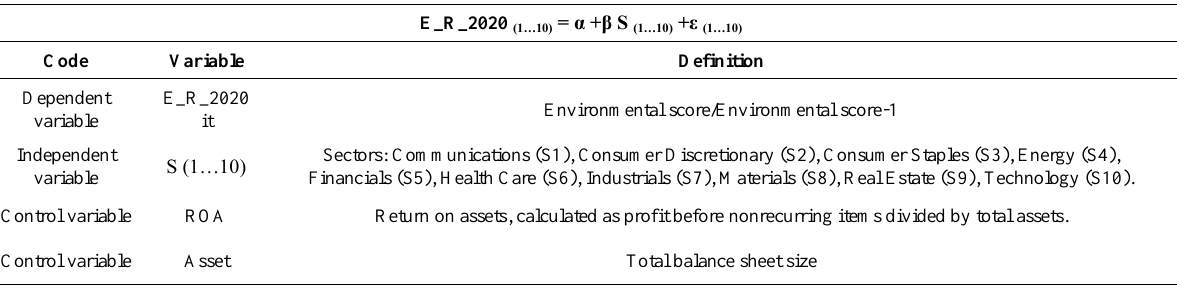
Table 3. OLS regression estimation dummy variables for sectors (EViews